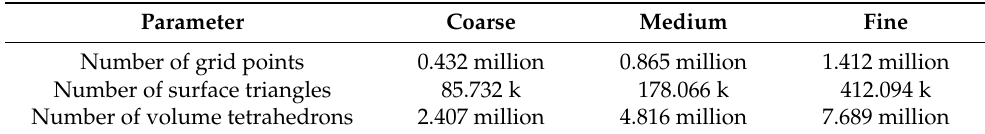
Table 2. Mesh densities used for mesh independency study.